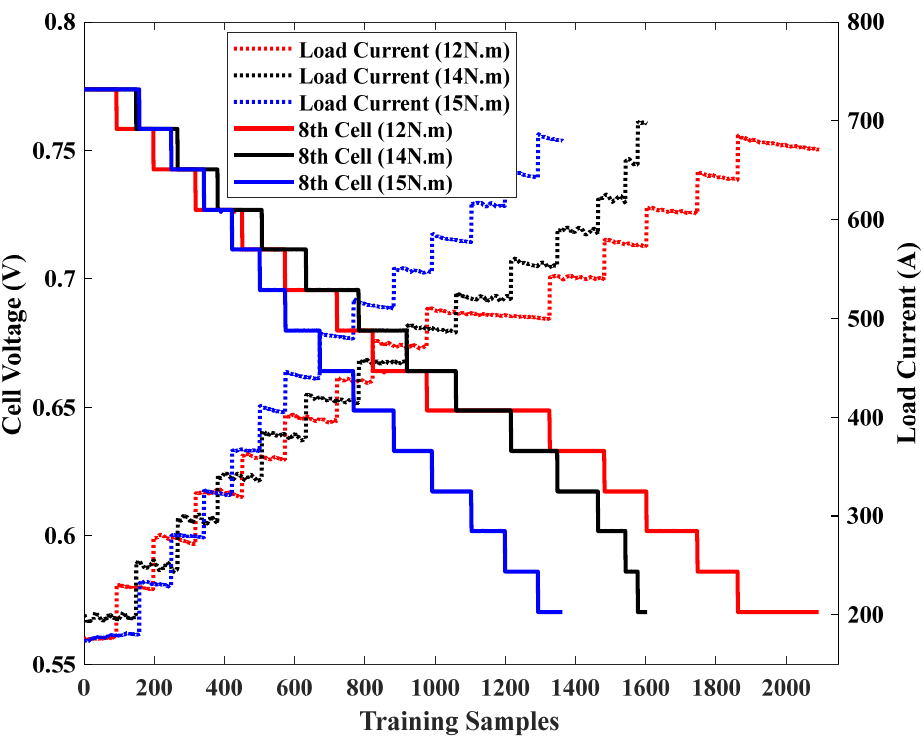
Figure 4. The load current and cell voltage curves under steady-state tests at assembling torques of 12 N.m, 14 N.m, and 15 N.m, respectively. Table 2. MSE , R 2 , Training Time , and the ANN structure in each group.